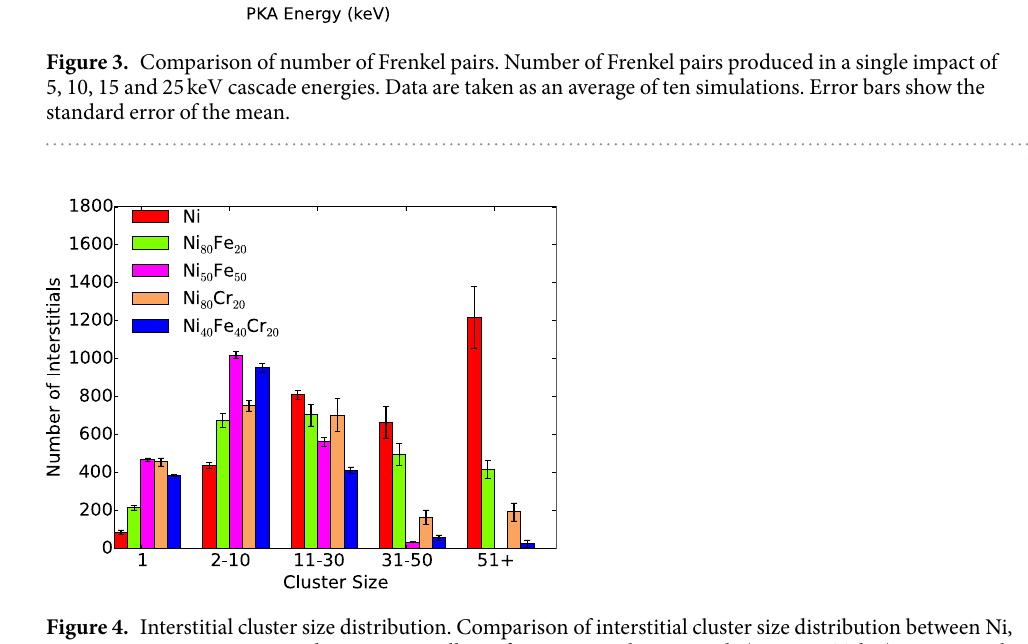
Figure 4. Interstitial cluster size distribution. Comparison of interstitial cluster size distribution between Ni,